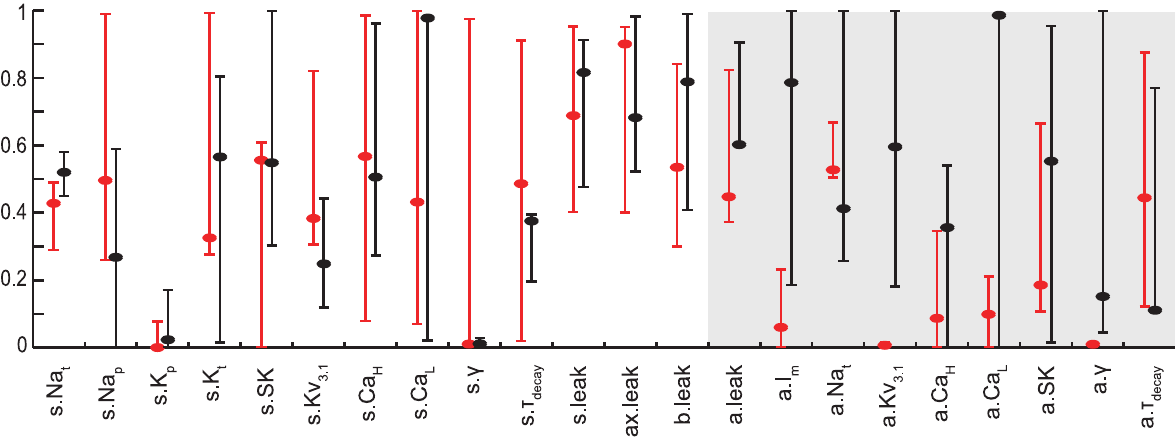
Figure 3. Parameter ranges for acceptable models for either perisomatic step current firing or BAC firing. Distribution of normalized parameter values in models constrained by BAC firing (red, n=899 acceptable models) or by perisomatic step current firing (black, n=52 acceptable models). For ease of viewing, the graph region containing parameters at the apical tree is shaded in gray. Red and Black circles correspond to specific normalized parameter values of the models shown in Figures 1 and 2, respectively. Real values for the different ion conductances can be derived by referring to the upper limits given in Table 2.